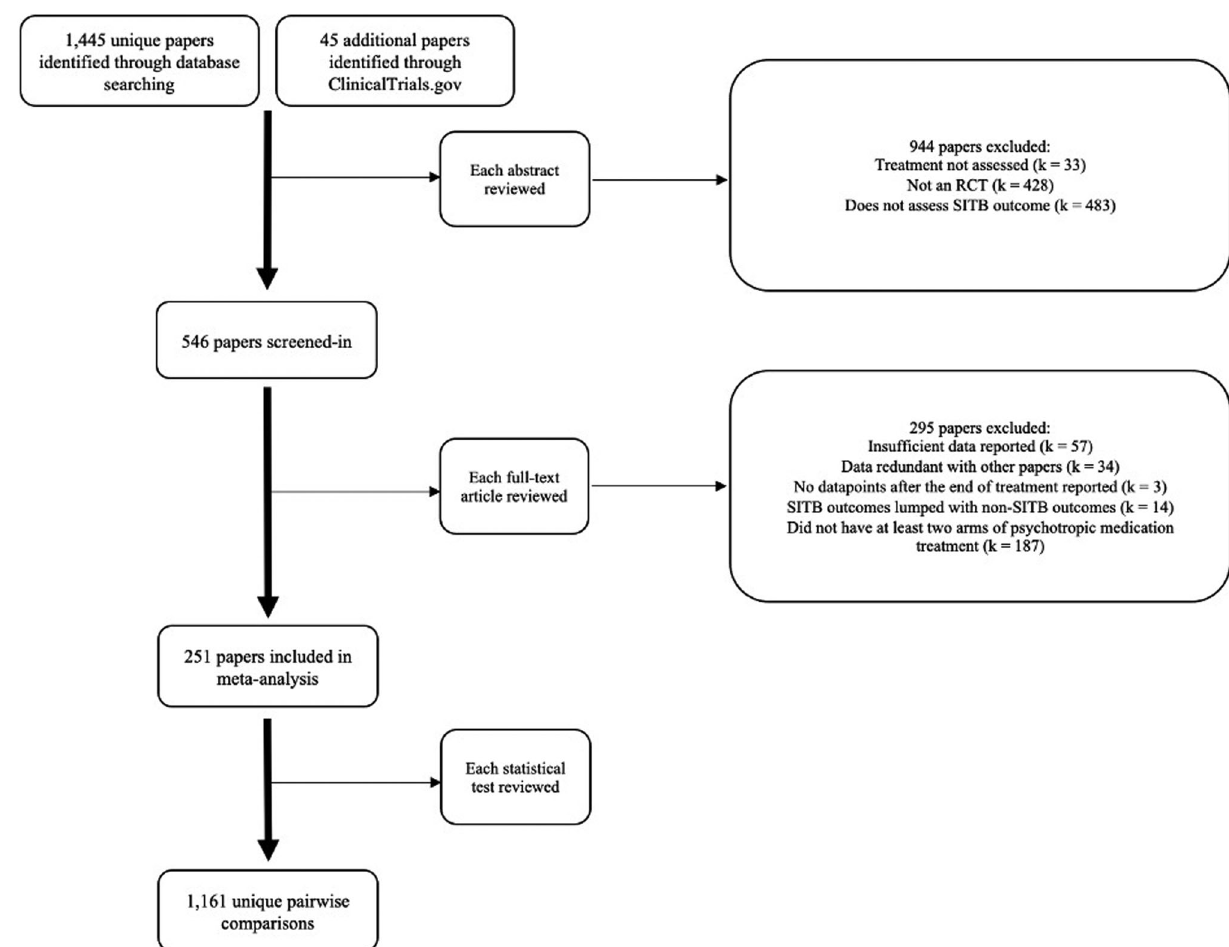
Fig. 1 PRISMA Diagram. Flow diagram showing the study selection